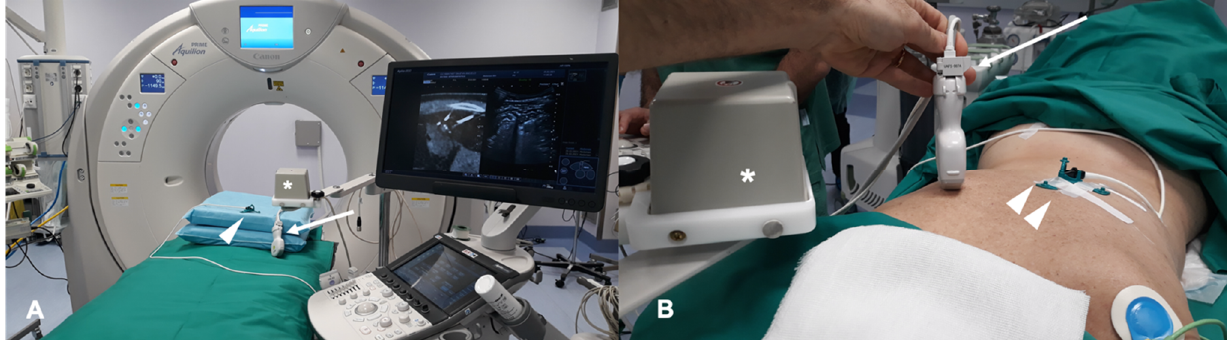
Figure 1. Operating room equipment for fusion imaging: ( A , B ) Computed Tomography (CT) scan gantry and ultrasound system for automatic image registration of fused images thanks to a disposable locating device visible under CT (white arrow heads), an ultrasound probe sensor (white arrow) and electromagnetic generator (white asterisk).